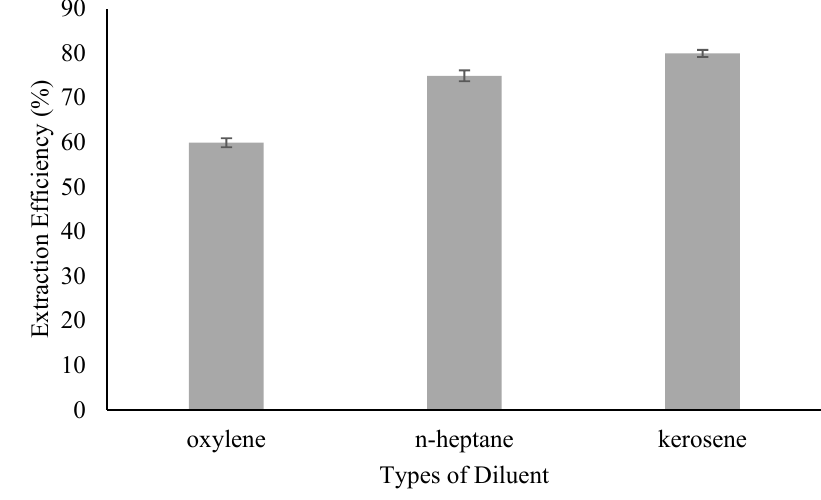
Figure 1. E ff ect of type of diluent on extraction e ffi ciency.